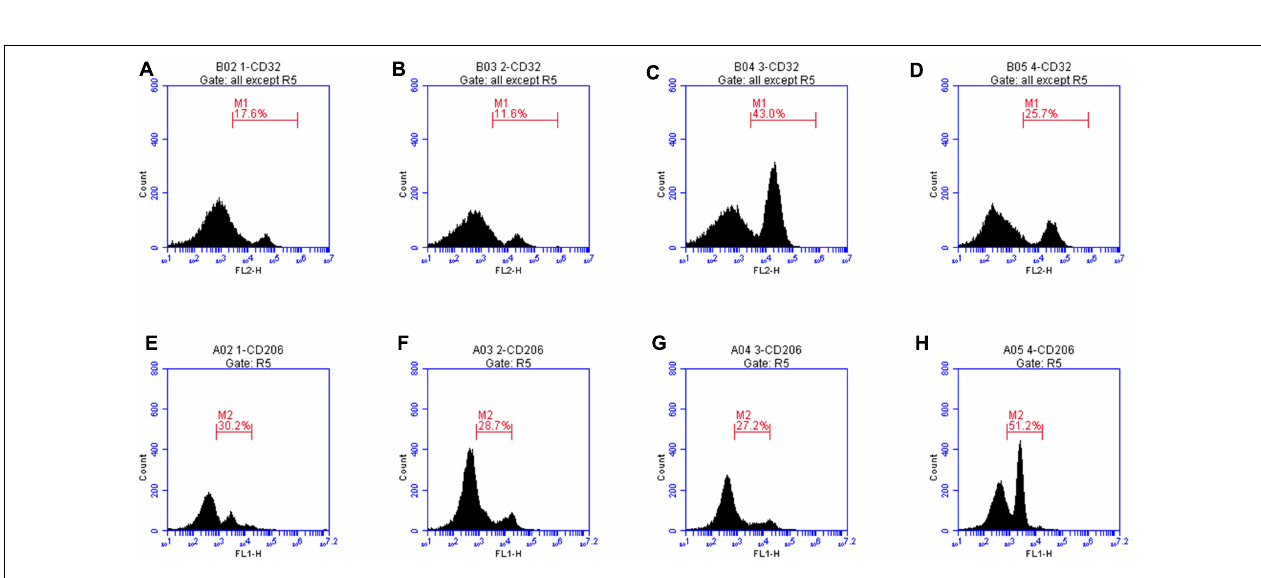
Frontiers in Cellular Neuroscience |